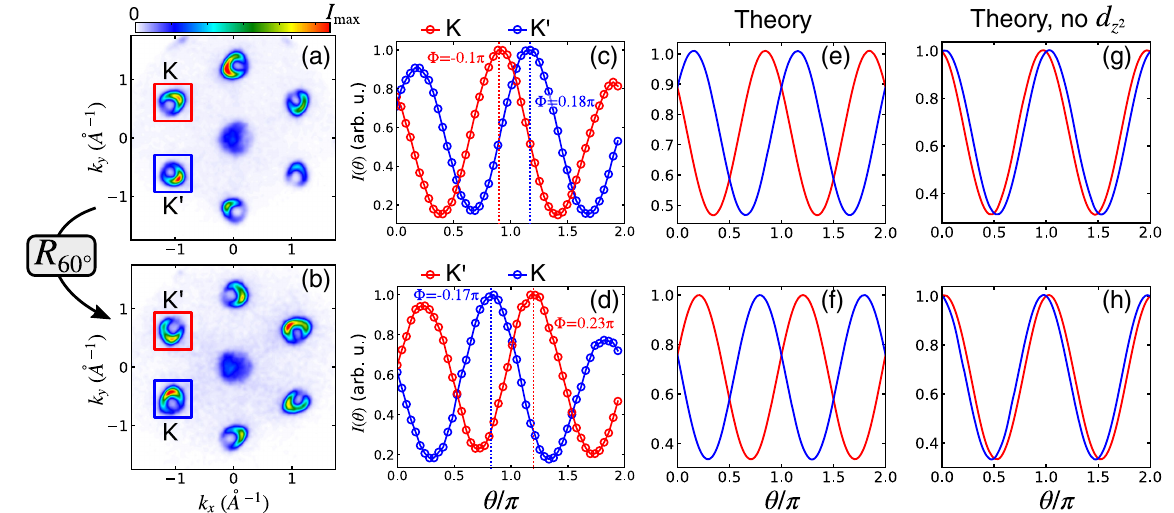
FIG. 3. Valley-resolved polarization-modulated photoemission. (a,b) Constant energy contours (binding energy E − E − 0 . 25 eV) for both crystal orientations (averaged over all polarization angles θ ). (c,d) Valley-dependent polarization-modulated photoemission signal, integrated over the square boxes shown panels (a) and (b). The θ dependence follows the generic form (2); the phase shift Φ is illustrated by the dotted lines, and the value of Φ for the K = K 0 valleys is given in the corresponding color. (e,f) Calculated polarization-angle modulation of the intensity [analogous to panels (c) and (d)]. (g,h) Analogous to panels (e) and (f), but excluding the j d i orbital contribution. The direction of the light incidence is in the x - z z 2